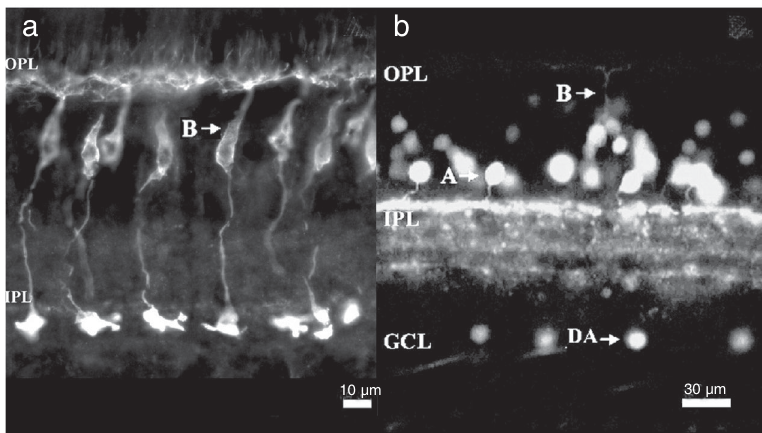
Figure 1. Distribution of PKC-IR and PV-IR in cross-sections of the fish retina. a , PKC-IR bipolar cells (B) sending their dendrites to the outer plexiform layer (OPL) and their axons to the inner plexiform layer (IPL) can be observed. b , Arrows indicate examples of PV-IR amacrine cells (A) between the OPL and IPL, displaced amacrine cells (DA) in the ganglion cell layer (GCL), and a bipolar cell (B). PKC-IR = immunoreactive protein kinase C; PV-IR = immunoreactive